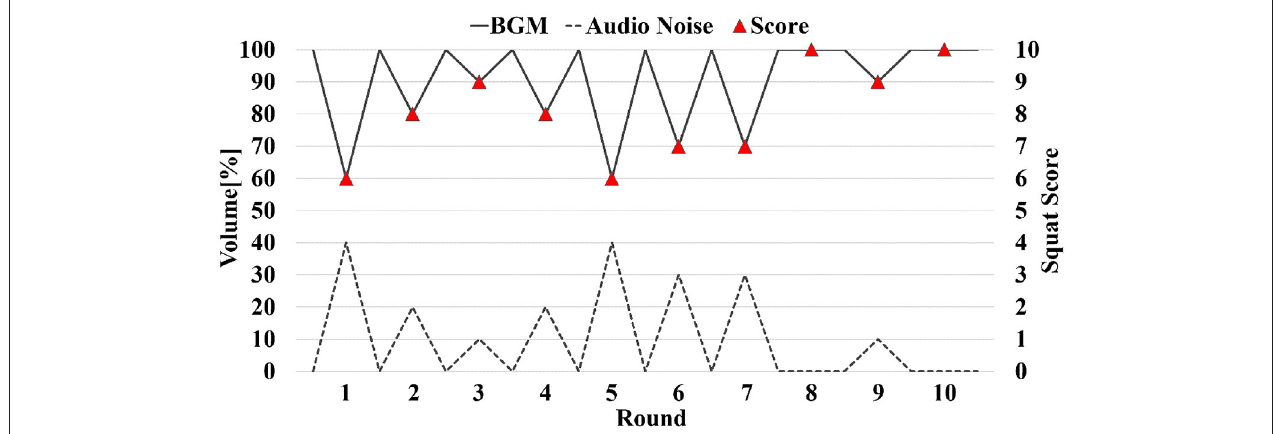
FIGURE 4 | Image of interactive music feedback. The X-axis indicates the squat round, left vertical axis is the volume of BGM and audio noise, and the right vertical axis is the squat score.